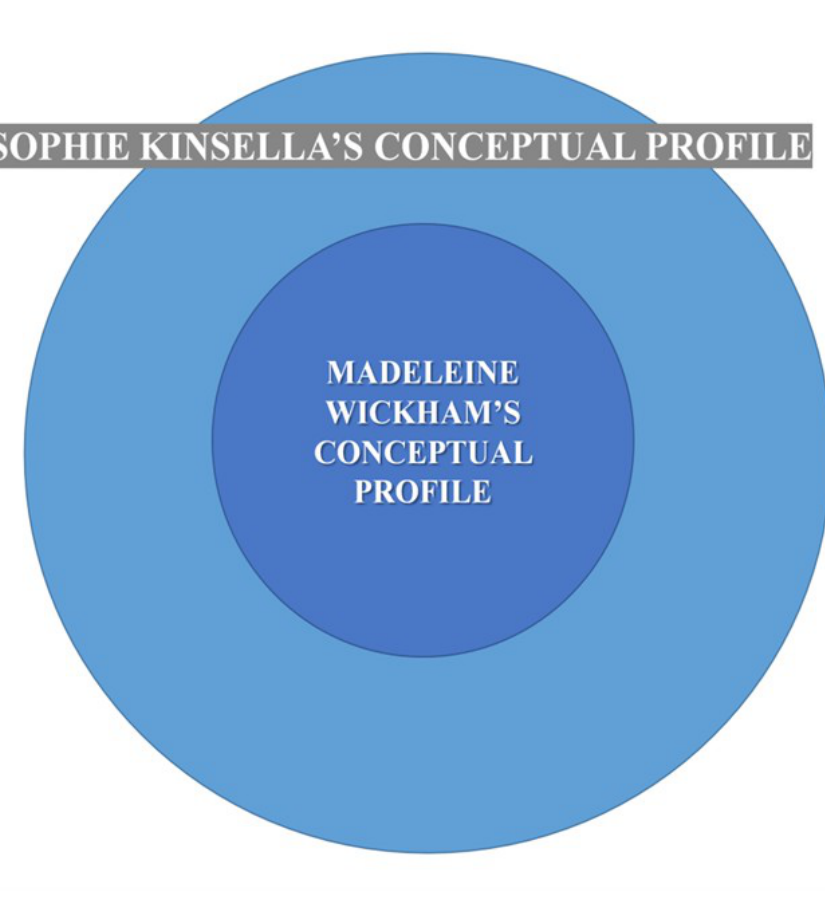
Figure 1 - The model of S. Kinsella’s conceptual